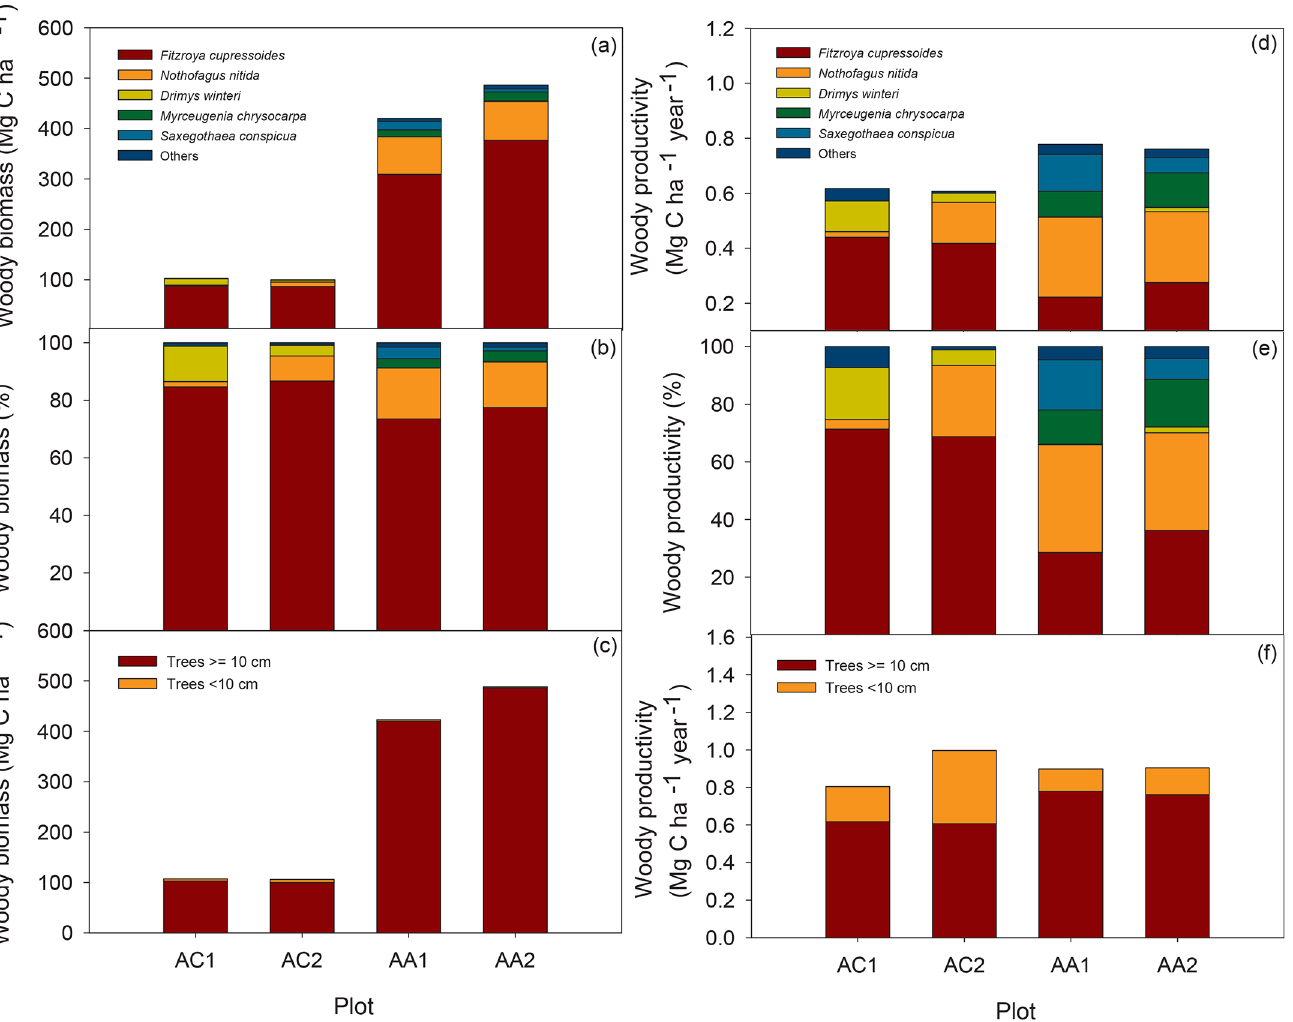
Fig 2. Aboveground woody biomass and productivity per species and plot. Left panel: a) Aboveground woody biomass per species in all trees (cid:1) 10 cm diameter, b) proportion of the woody biomass presented in a) contributed by the different species in percentage (%) and c) woody biomass contributed by the large (trees (cid:1) 10 cm DBH) and small (trees < 10 cm DBH) tree components within each plot. Right panel: d), e), f) the same as a), b) and c), respectively, but for aboveground woody